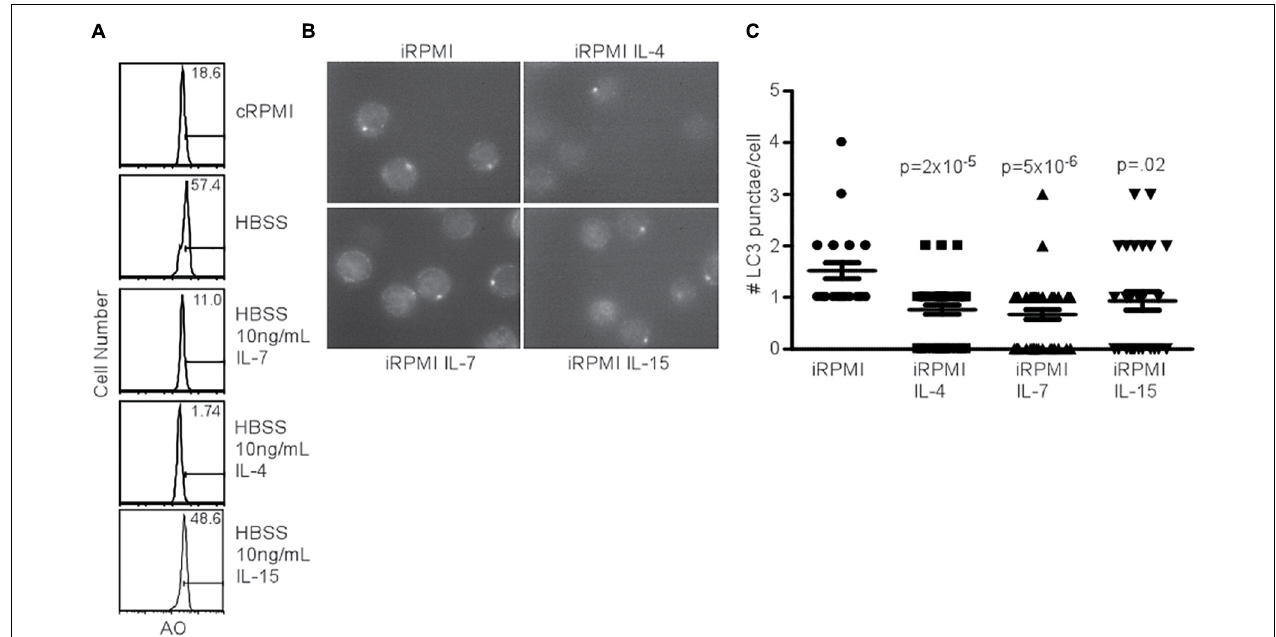
FIGURE 3 | Common gamma chain cytokines inhibit starvation-induced autophagy. (A) AVO profiles of naïve CD4 T lymphocytes starved in HBSS for 48 h with the indicated cytokines. Histograms are representative of 3 independent experiments. IL-4 and IL-7 had potent effects on starvation-induced AVO formation, while IL-15 had a less drastic effect. (B) Fluorescence microscopy of LC3 aggregates in naïve, starved CD4 T lymphocytes treated with the indicated γ c cytokines for 48 h, permeabilized, and stained with anti-LC3. Data are representative of fields observed. (C) Quantitation of (B) , with at least 30 cells counted for each condition in two independent experiments. The indicated cytokines significantly reduced LC3 punctate formation. P -values are from unpaired, two-tailed Student’s t